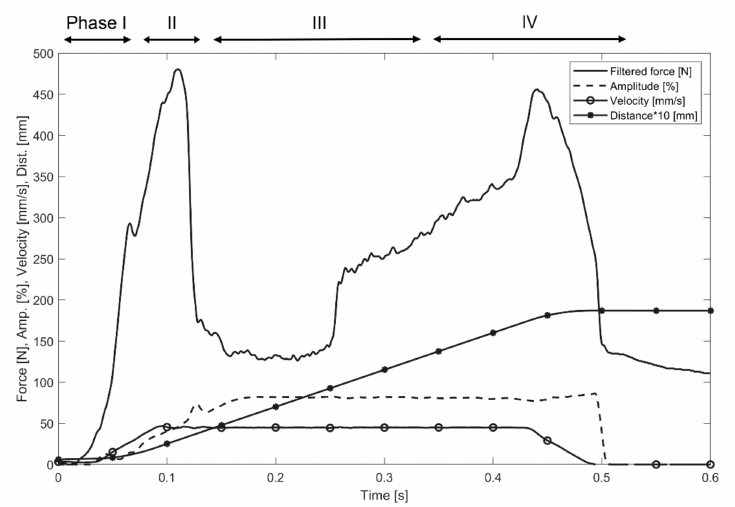
Figure 4. Process signals such as filtered force, amplitude, and velocity during the LiteWWeight ® joining process of a thermoplastic pin with the sandwich-structured composite